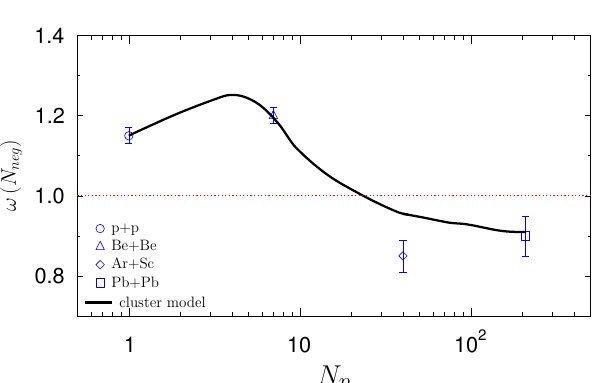
Figure 2. Average number of all charged particles (panel a)) and scaled variance of all charged multiplicity distribution (panel b)) of particles produced in Pb + Pb collisions plotted as a function of number of nucleons from projectile nucleus which participate in the collision. By triangles we indicate data of the NA49 experiment [3]. Figure 4. Scaled variance of negatively charged multiplicity distribution of particles produced in proton + proton and the most central (1%) Be + Be, Ar + Sc and Pb + Pb collisions, and emitted to the forward hemisphere, y π > 0 plotted as a function of number of nucleons from projectile nucleus which participate in the collision. Symbols present data of the NA49 and NA61 / SHINE experiments [7, 8]. With the line we show results obtained using our